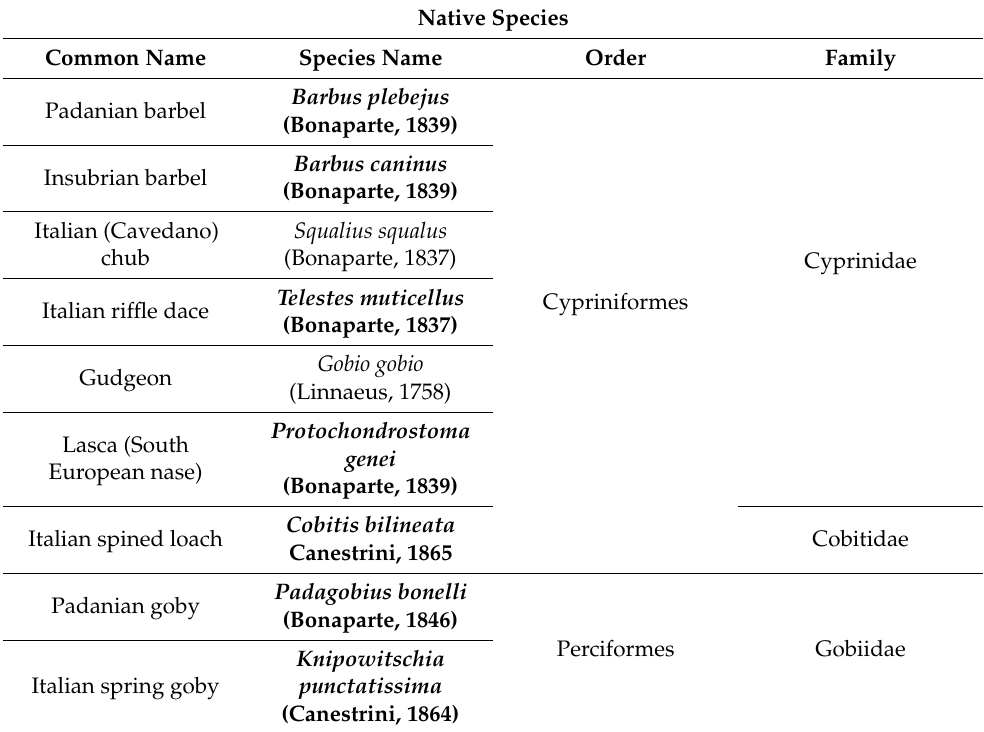
Table 2. Native species sampled during the field campaigns (endemic species in bold), in accordance with Zerunian et al. [4].